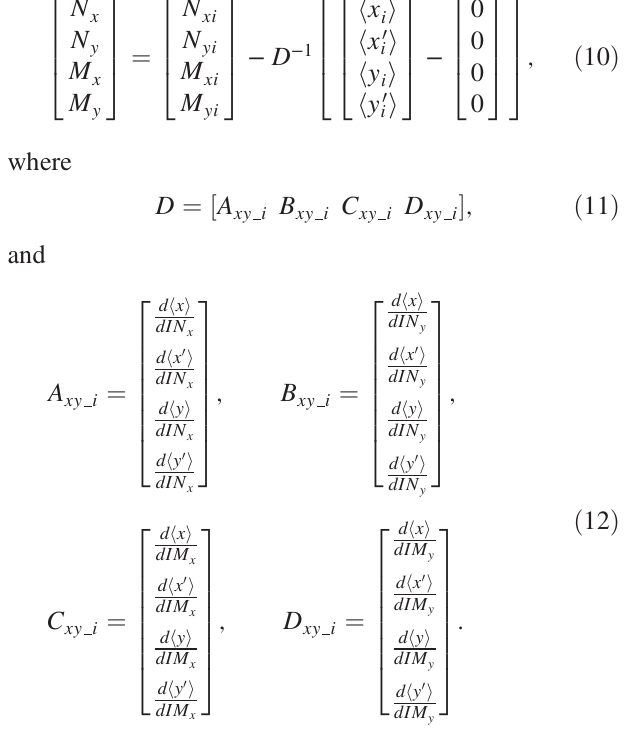
FIG. 3. (a) Calculated beam centroid oscillations corresponding to the 2.9 kA tune with initial position offsets only, (b) measured beam centroid offsets running this tune, (c) normalized measured betatron oscillation of the beam centroid (note scale h y i ¼ (cid:3) 0 . 65 mm, close to the maximum excursions calcu-